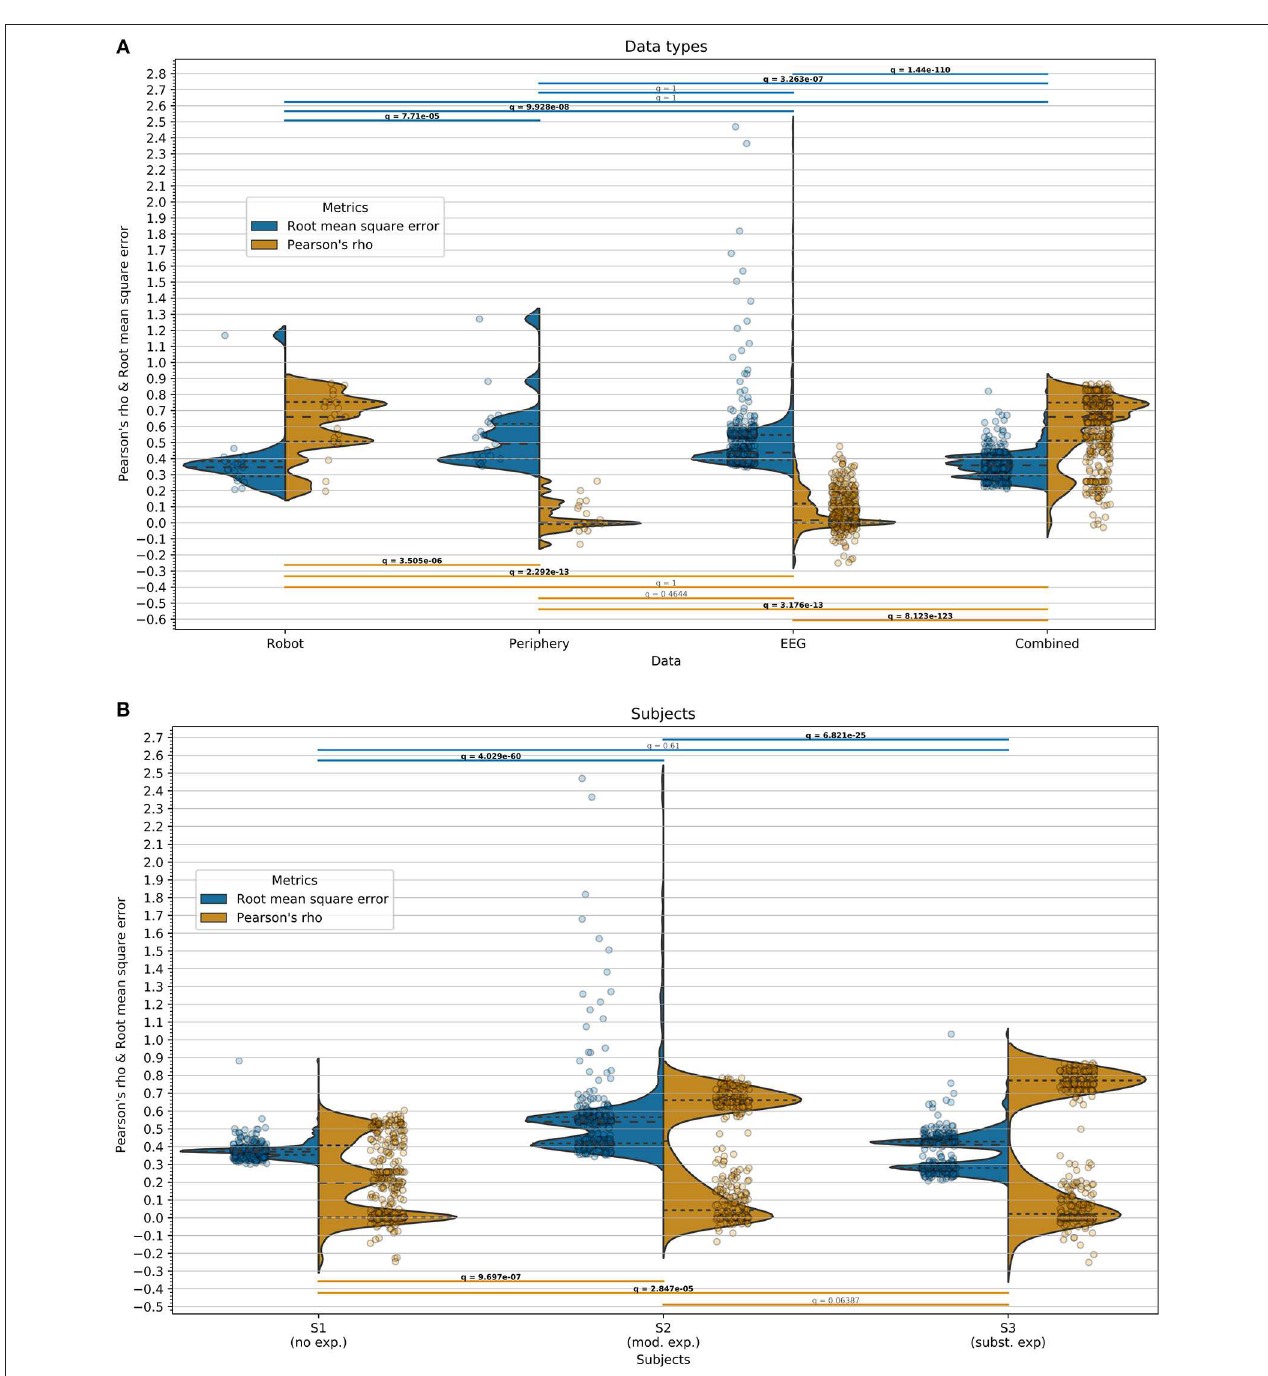
FIGURE 9 | Regression within users. Pearson’s ρ (orange, higher is better) and the RMSE (blue, lower is better) are displayed separately in split violins. As test-set, the last 3 min of the experiment was used for each user. The dashed lines within the split violins represent the quartiles (from bottom to top, 25th, 50th, and 75th percentiles, respectively). Overlaid to the split violins are dot-plots with horizontal jitter (for better visibility) representing the data sample underlying the split violins. The horizontal bars above and below the split violins indicate the performed significance tests with matching q-value (FDR-corrected p -value). Bold font indicates q < 0.05. The evaluation metrics with their corresponding half-violins, dot-plots, and significance bars are color-coded. (A) Regression results split across data types: 21 or 441 test-set regressions per split violin (3 users · 1 features · 7 models or 3 users · 21 feature · 7 models). Significance (unpaired: Mann–Whitney-U, paired: sign-test) FDR-corrected for 6 tests. Separate corrections for each metric. (B) Regression results split across users: 308 test-set regressions (44 features · 7 models) per split violin. Significance (sign-test) FDR-corrected for 3 tests. Separate corrections for each metric.